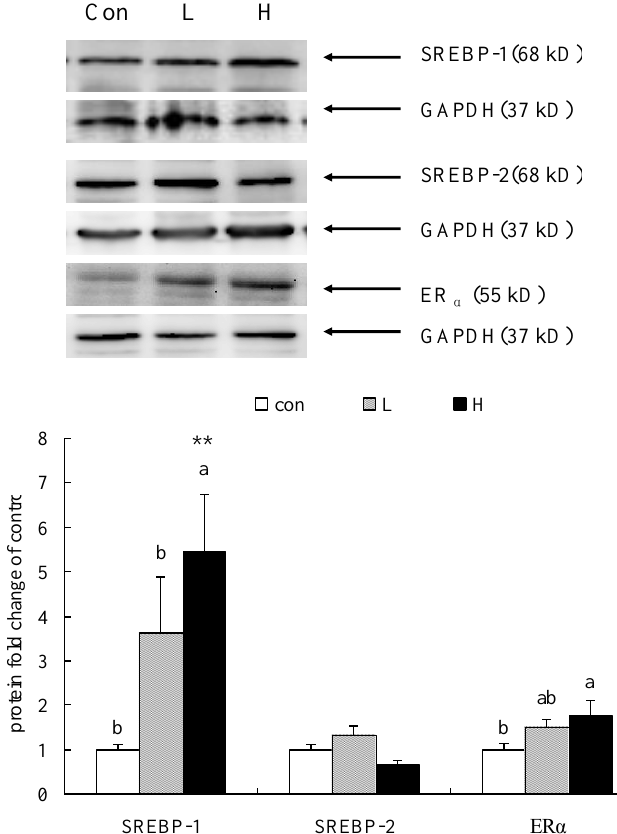
Figure 5. Effects of Kp-10 on the hepatic expression of SREBP-1, SREBP-2 and ER  proteins in quails. Values are means  SE of fifteen replications. The data points without same superscripts (a, b) are significantly different (one-way ANOVA) at the level of p<0.05 and ** at the level of p<0.01 (compared with control) by least square difference